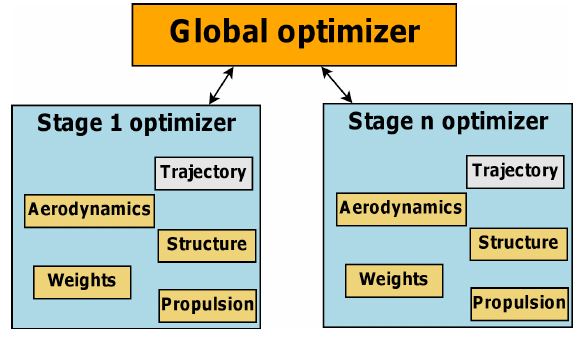
Fig. 4. Stage-wise decomposition